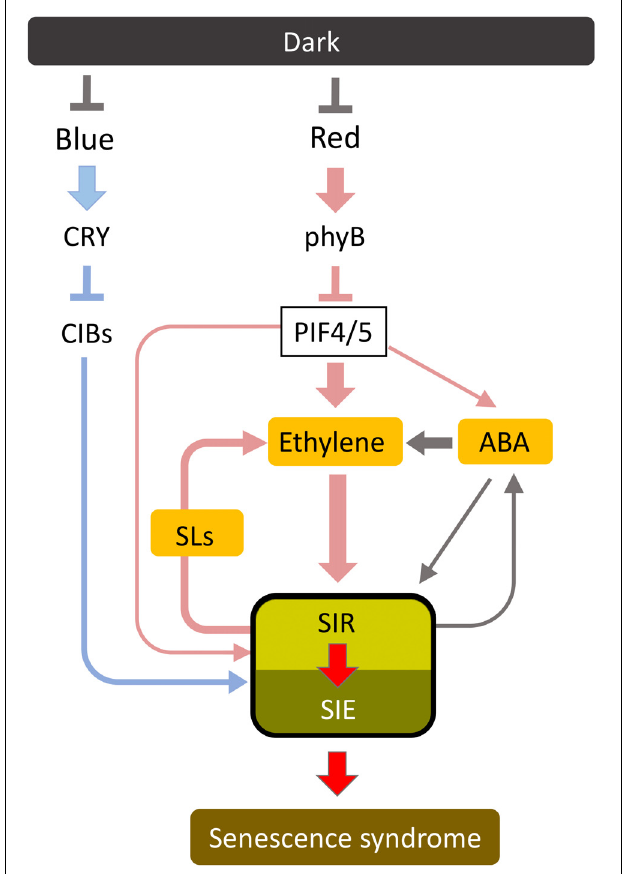
FIGURE 5 | A proposed signal transduction pathway of dark-induced senescence. Dark-induced senescence is mainly regulated by the red light pathway involving phyB and PIF4/PIF5. PIF4 and PIF5 regulate ethylene synthesis and signaling to progress leaf senescence in addition to ABA signaling. ABA mainly promotes leaf senescence via ethylene signaling. PIF4 and PIF5 also directly regulate senescence-induced senescence